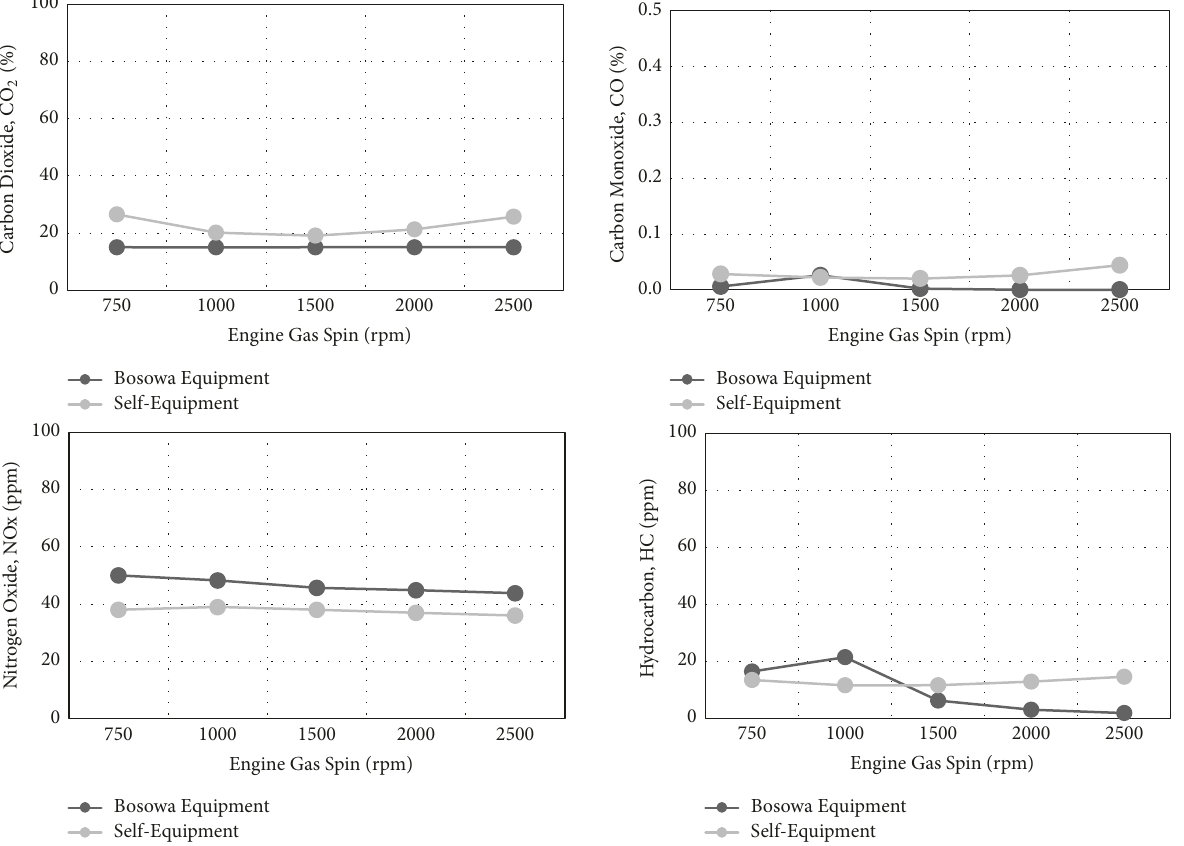
Figure 3: Comparison of emissions tests in PT. Bosowa Berlian Motor. (a) CO 2 . (b) CO. (c) NOx. (d)